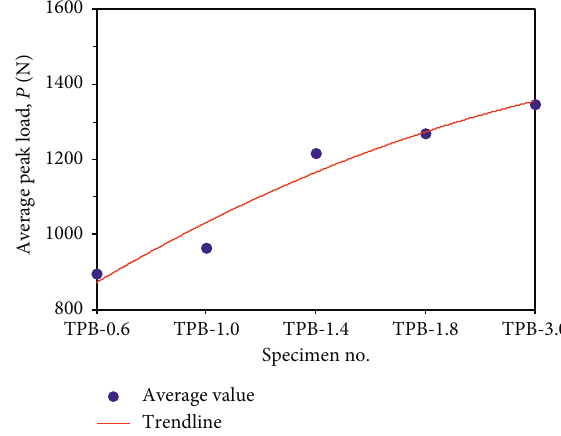
Figure 5: Average peak loads for the TPB tests on sandstone specimens under different loading